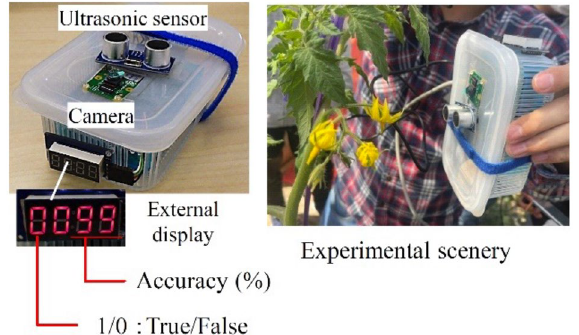
Figure 9. AI software implementation. An example and an image of an experimenter performing the experiment.